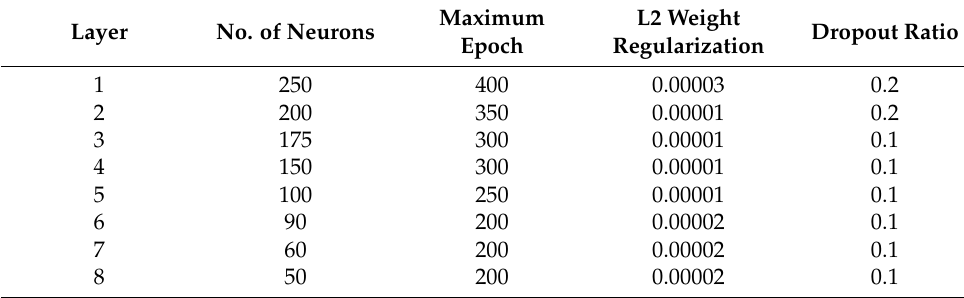
Table 3. The optimal fine-tuned configuration selected for Windfarm 3.